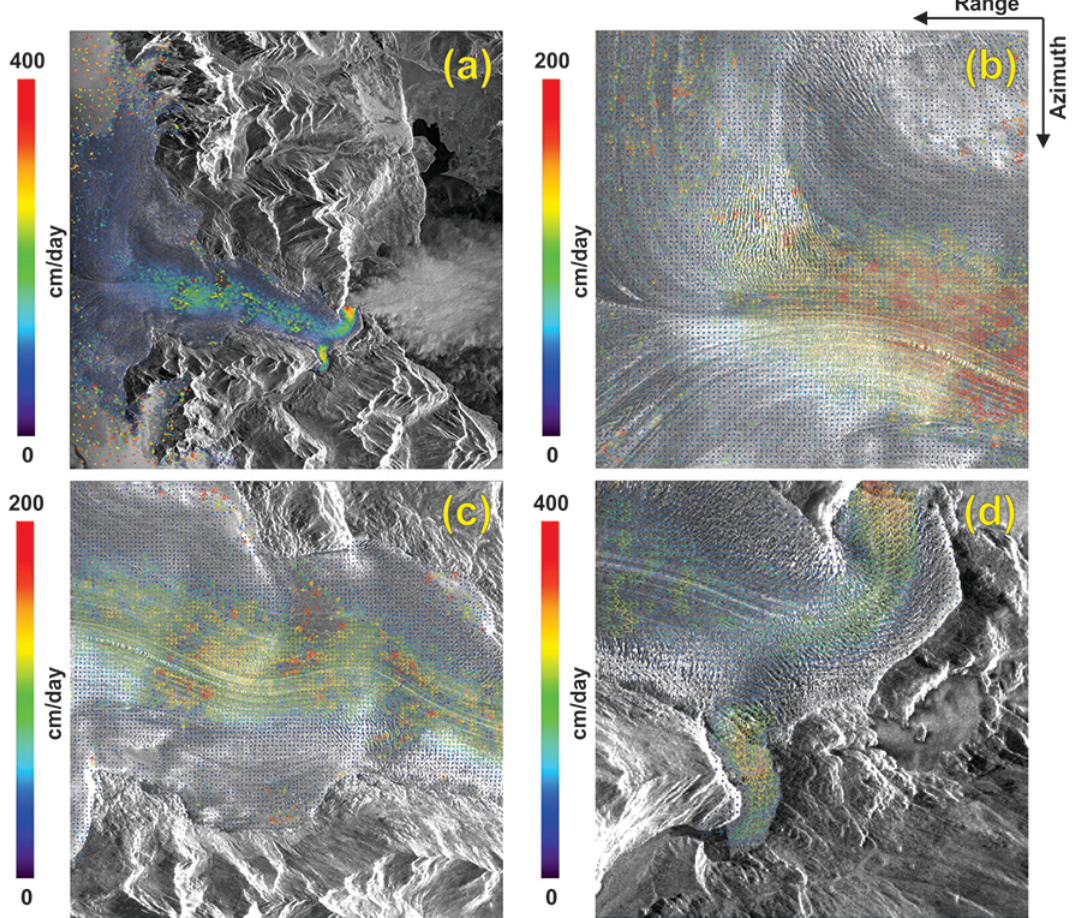
Fig. 6. Ice velocity field computed by Offset Tracking from COSMO-SkyMed descending tandem pairs (17–18 June 2012). (a) shows the area indicated by the yellow box in Fig. 1 and (b–d) are parts of the ice velocity map corresponding to the areas indicated in Fig. 4. (Note that the color bars are